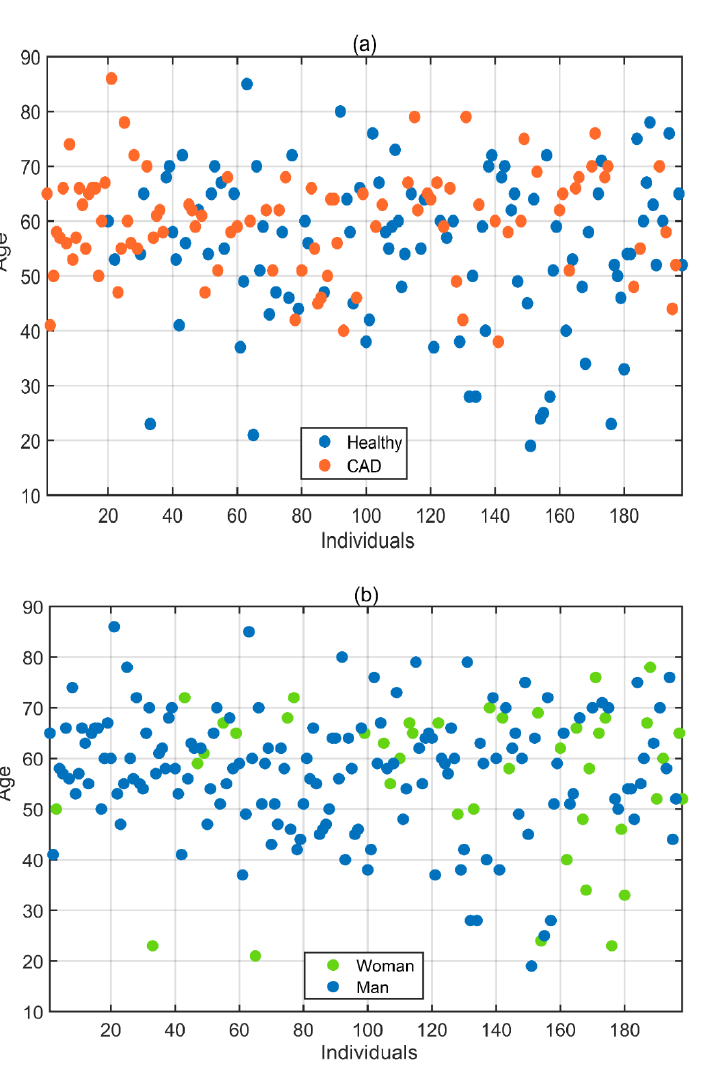
Figure 2. ( a ) Health status and ( b ) gender information displayed according to the ages of the vol- unteers. Table 1. Age and gender information of volunteers.